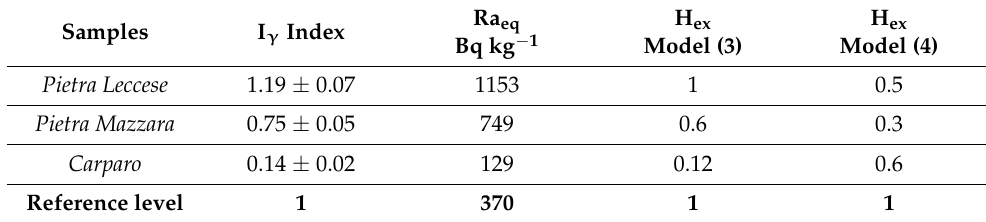
Table 4. Indexes results for measured